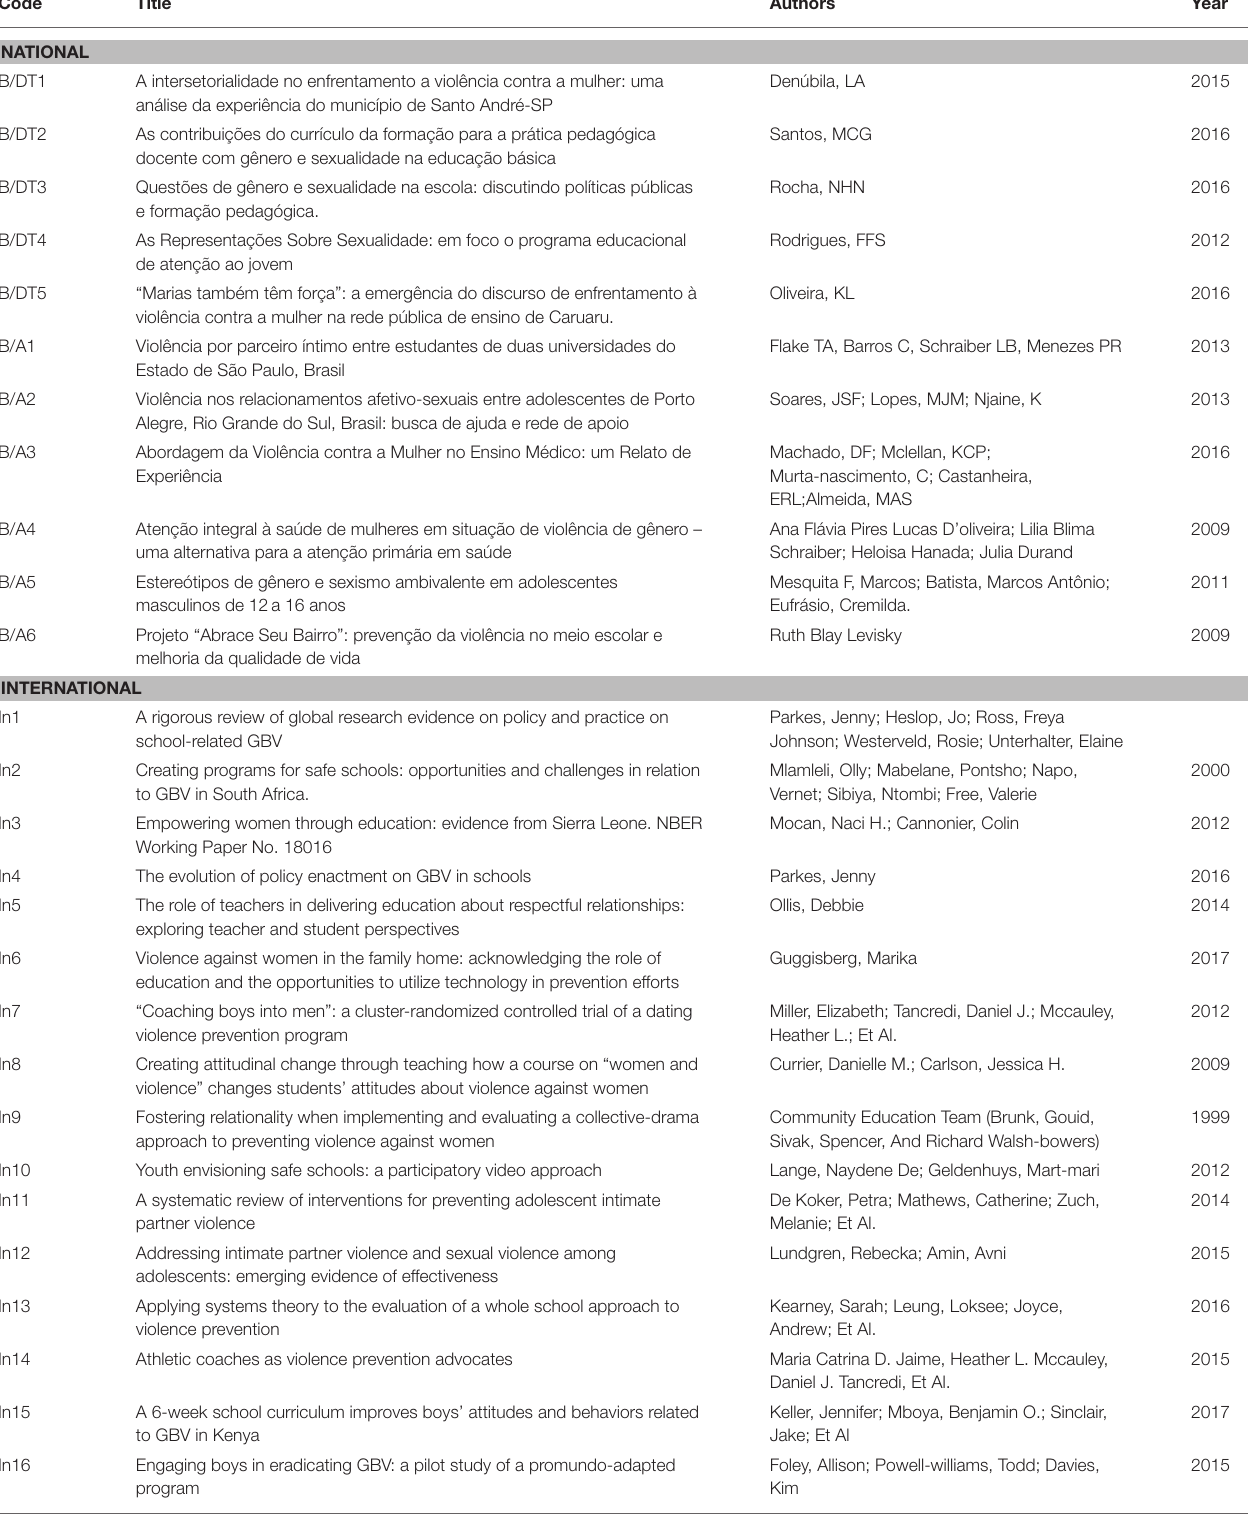
TABLE 1 | Codification of the works